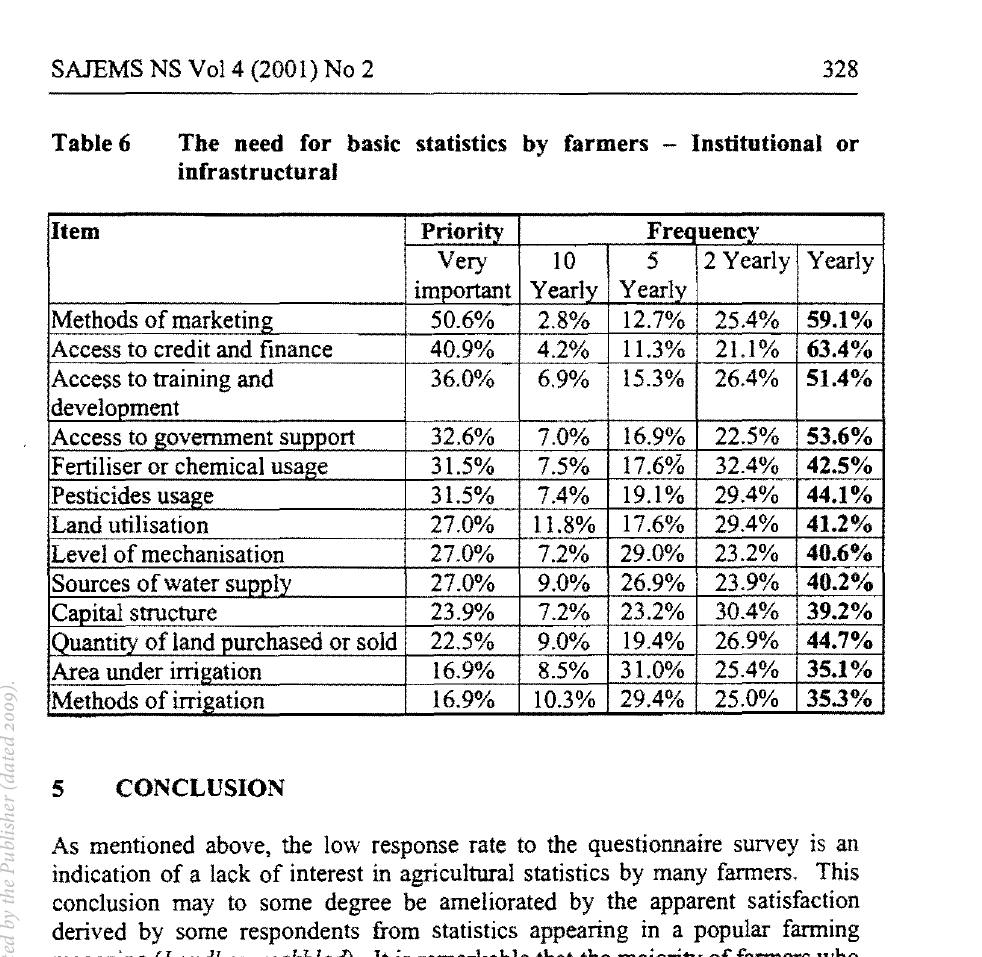
Tbe need for basic statistics by farmers - Institutional